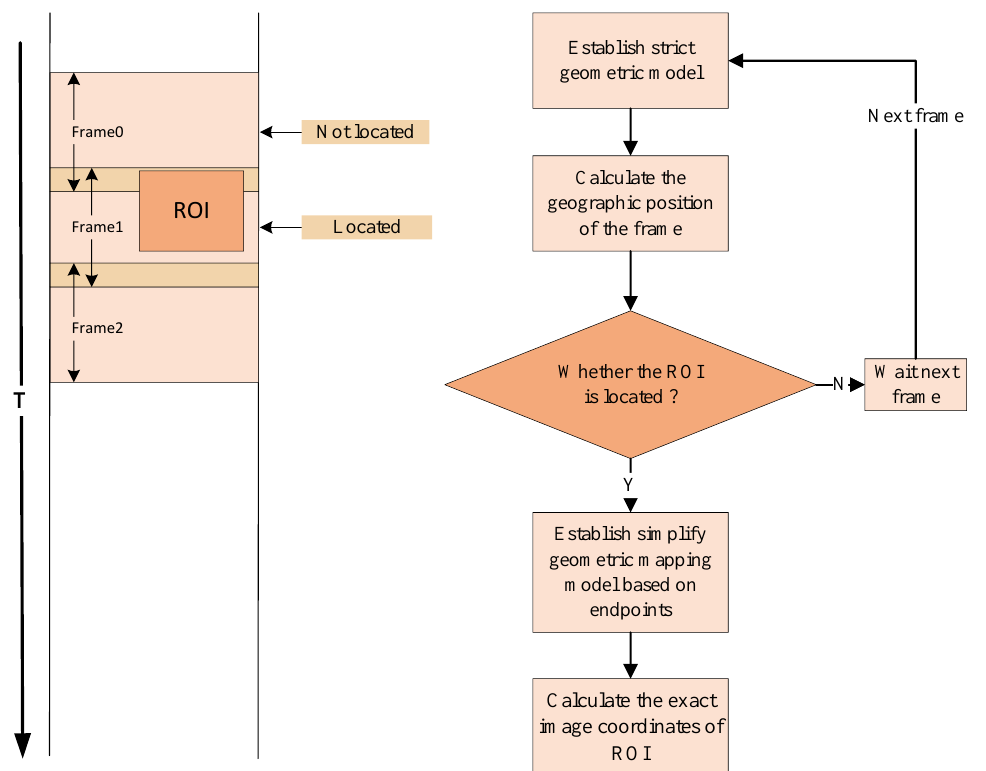
Figure 2. Flowchart of ROI location for frame array sensor data.